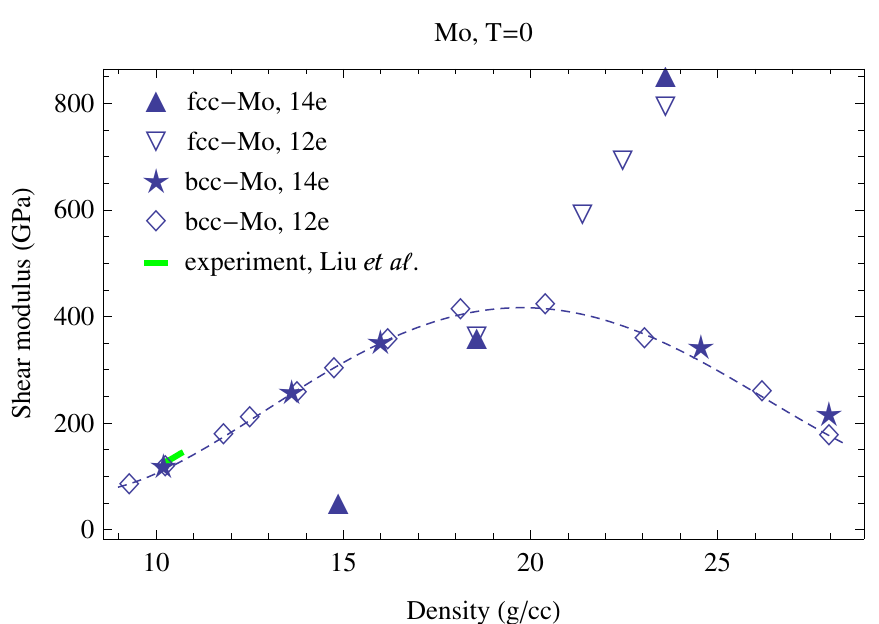
Figure 4. The lower-density portion of Figure 5. The experimental room- T data of Reference [38] covering a range of densities up to 10.654 g/cm 3 (pressures up to 12 GPa) are included. The dashed line represents Equation (26). 12e and 14e distinguish between the results obtained with 12 and 14 valence electrons,